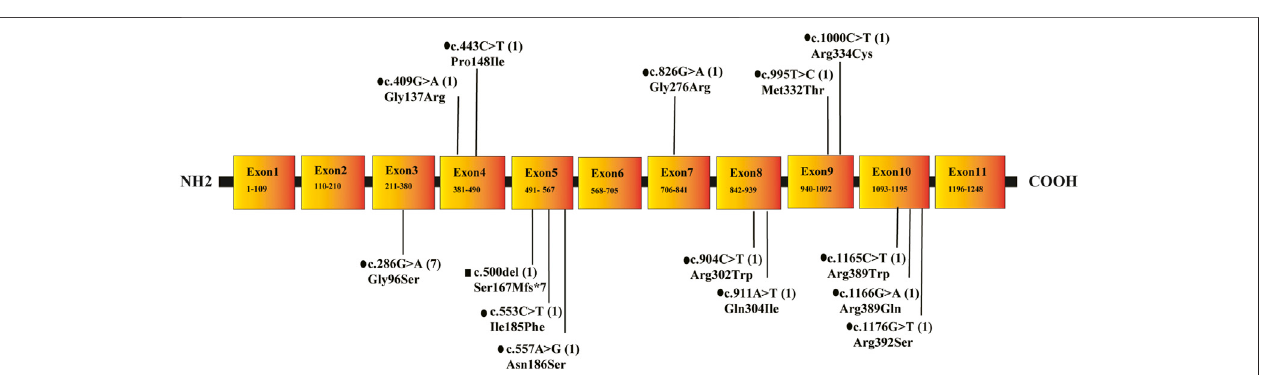
(cid:129) meansmissensemutation; ▪ indicatesaframeshiftmutationafter.